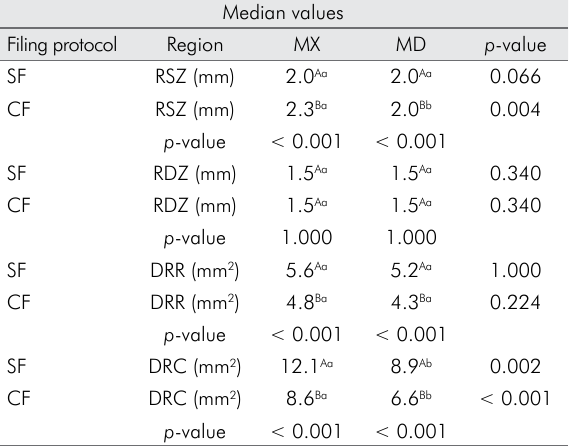
*Different capital letters indicate significant differences between the filing protocols (vertical). Small letters indicate significant differences between the groups (horizontal) ( p <